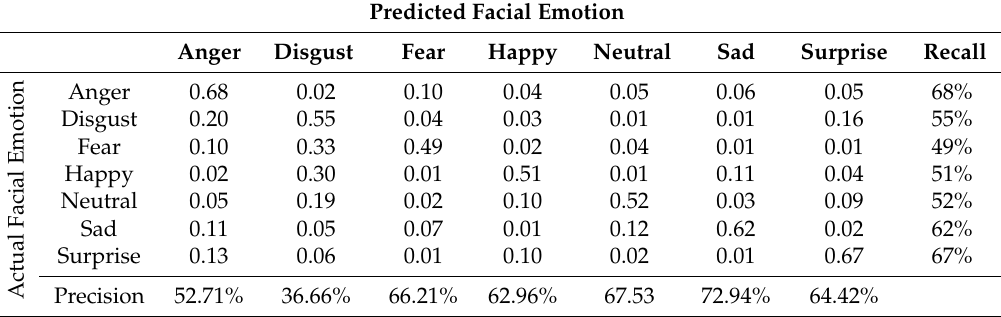
Table 1. Confusion matrix for the static facial expressions in the wild (SFEW) dataset. The results for seven emotions are